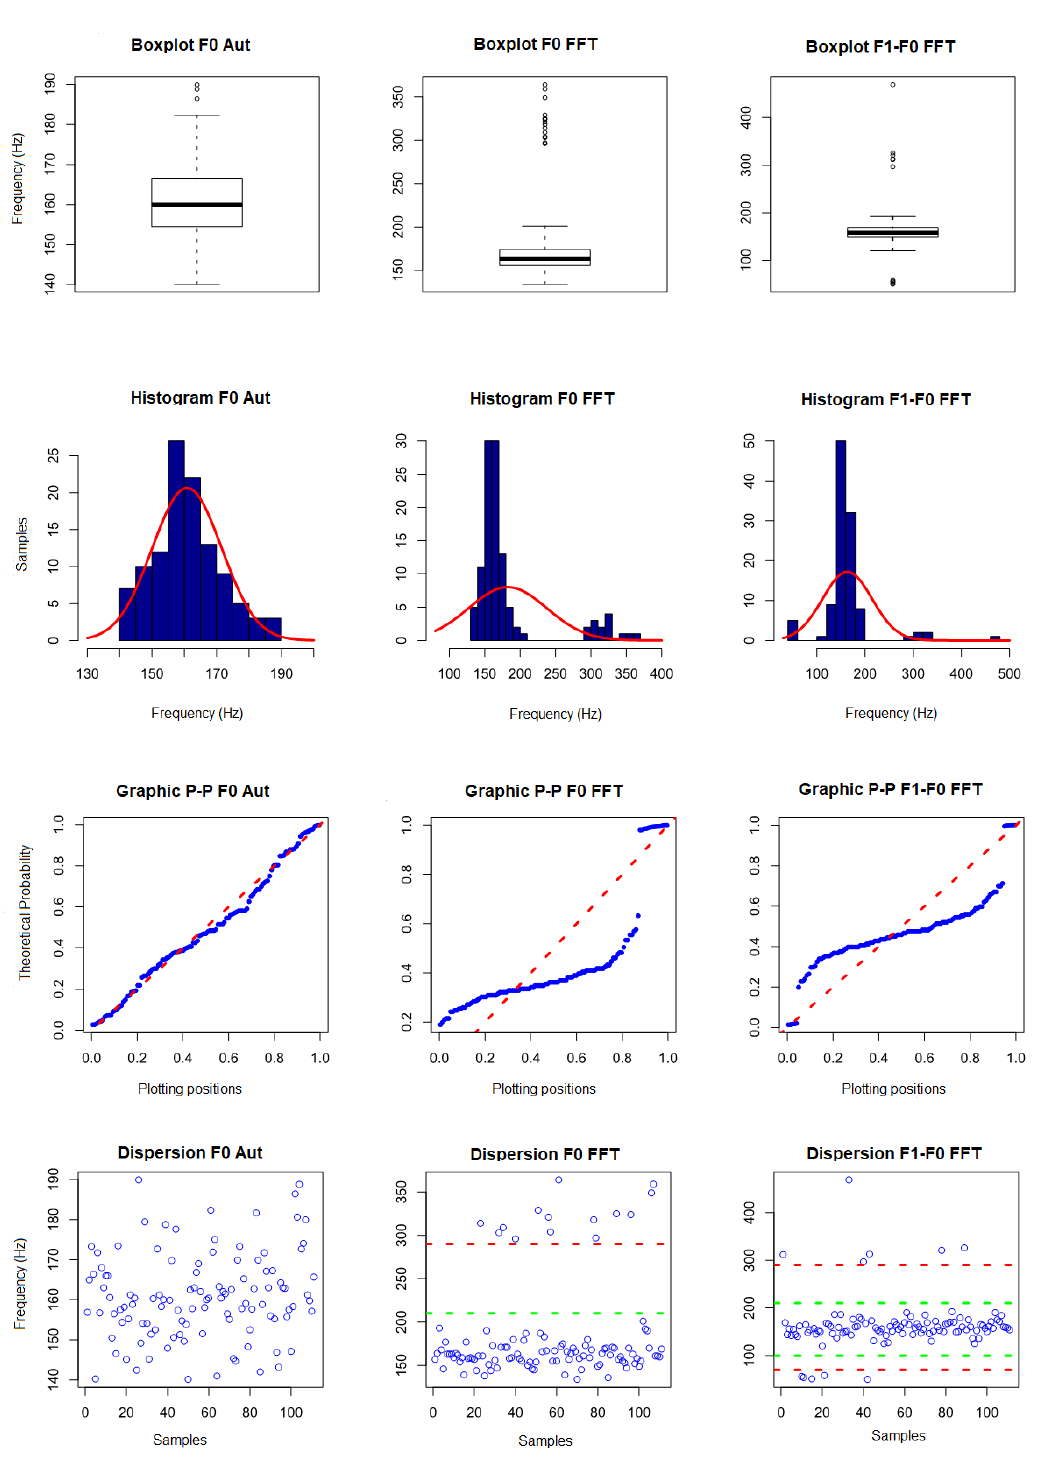
Figure 24. Graphics of the visual evaluation of the data obtained with the events of passage of the C. capitata of the standard group without removal of